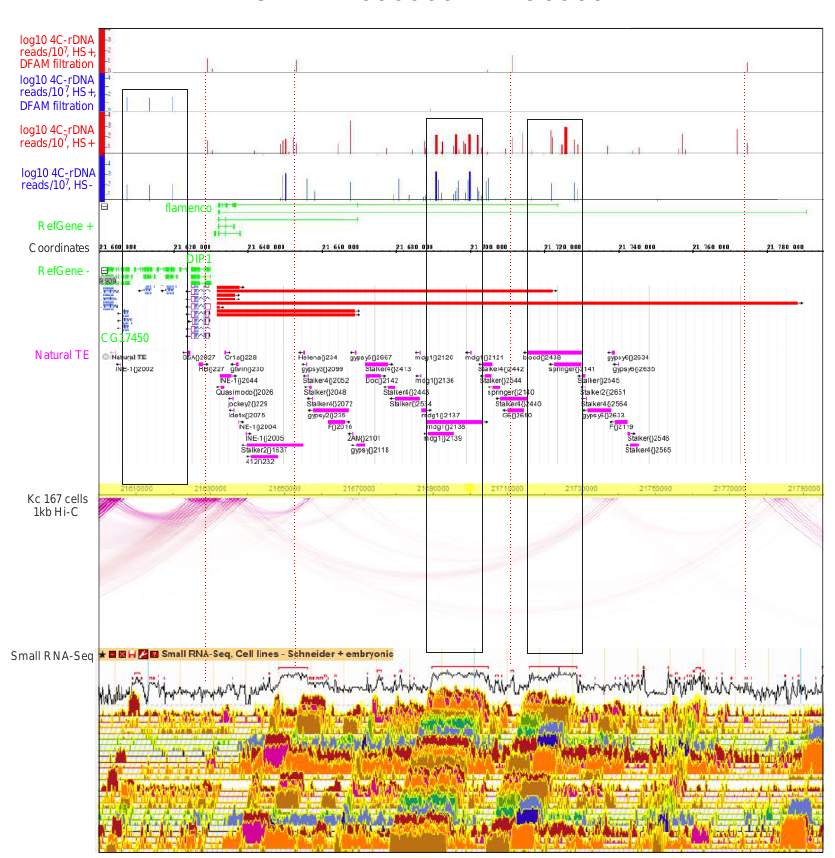
Figure 9. rDNA-contacting sites inside the flamenco locus. At the top, the rDNA contacts are shown in the IGB Browser for the mapped reads without Dfam filtering and after the filtering. The contacts in normal and heat-treated cells are shown in blue and red, respectively. The distribution of natural transposable elements and small RNAs are indicated as in the FlyBase Browser. The intra-chromosomal contacts detected in Kc 167 cells are shown as in the WashU EpiGenome Browser (https: // epgg-test. wustl.edu / browser / ). Long frames indicate two regions of rDNA contacts (without Dfam filtering) in the locus that correspond to mdg1 and blood